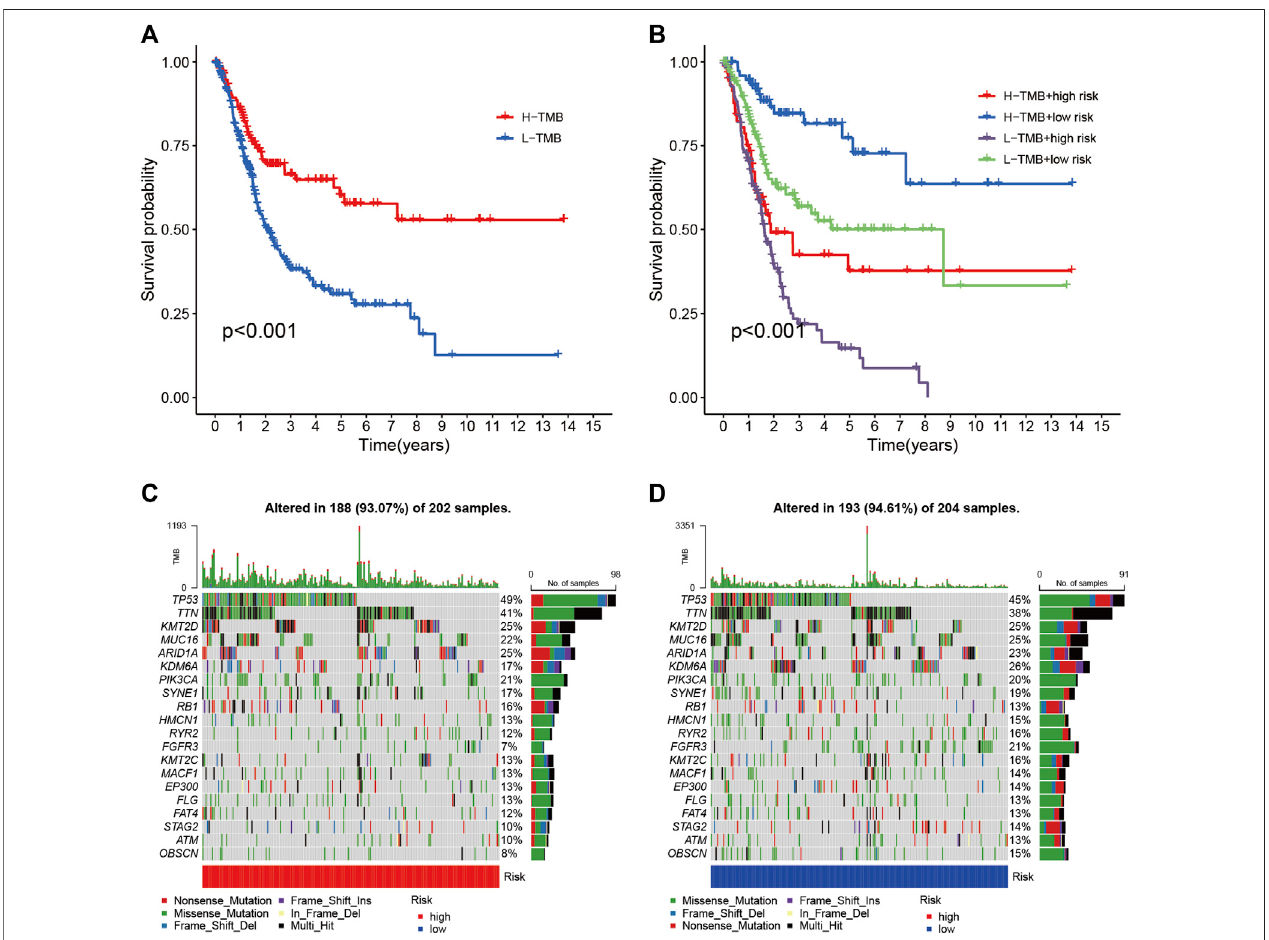
FIGURE 8 | Correlation between risk score and TMB (A) Kaplan-Meier curves of high TMB and low TMB groups (B) Kaplan-Meier curve strati fi cation of patients according to TMB and risk signature. The oncoPrint was constructed using high risk score (C) and low risk score (D) .